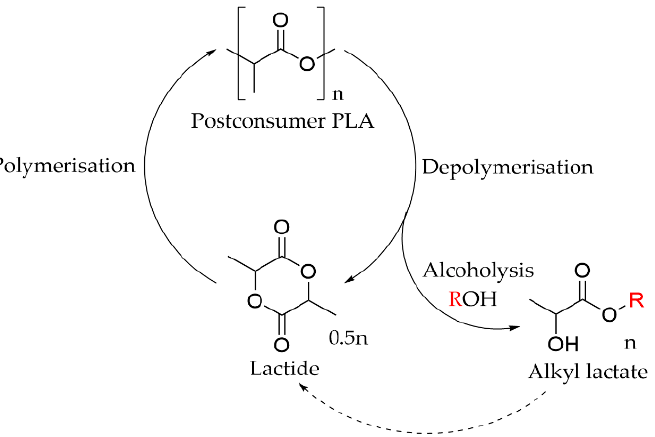
Figure 1. General scheme for the circular economy of PLA via chemical recycling. Alcoholysis allows for the generation of the value-added product AL.